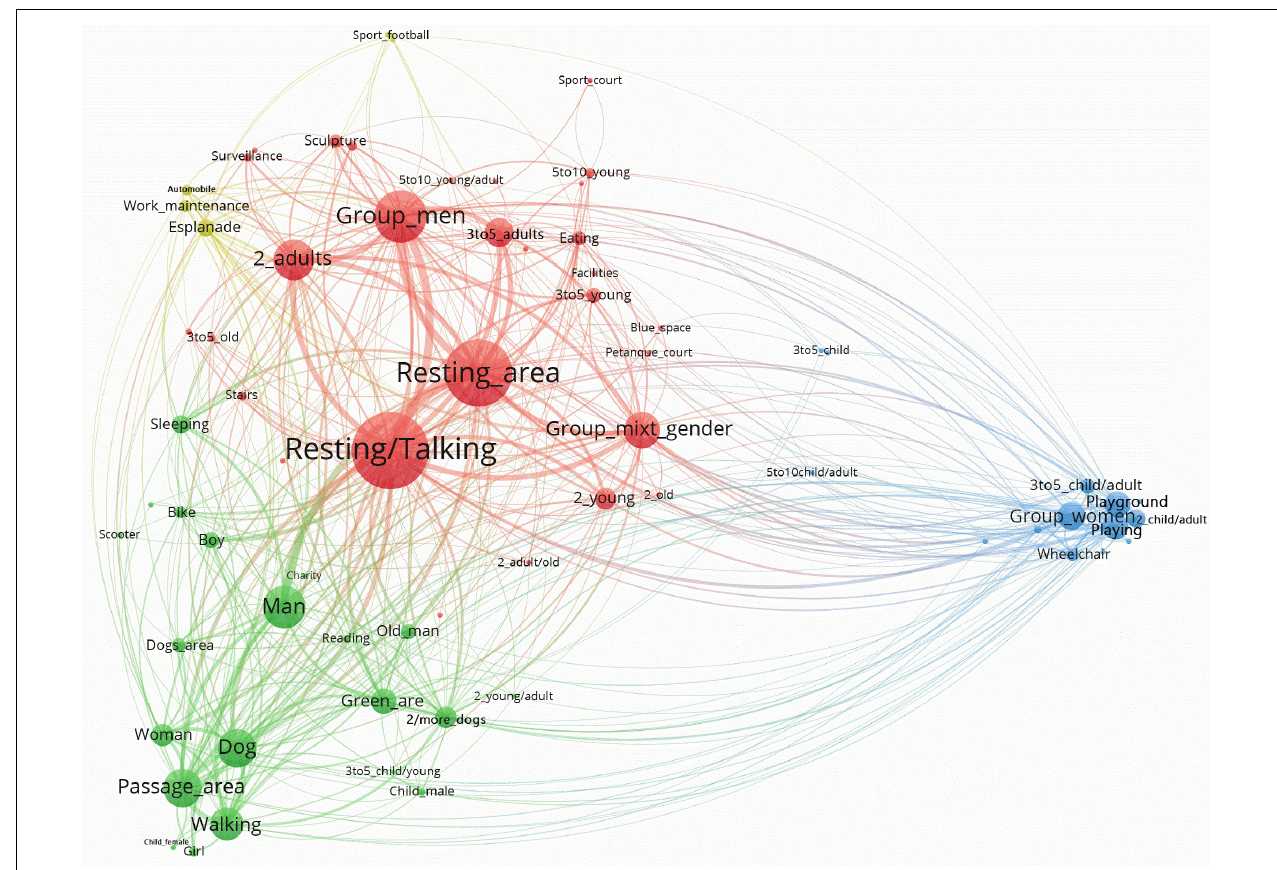
FIGURE 5 | St. Pau del Camp Garden’s network by